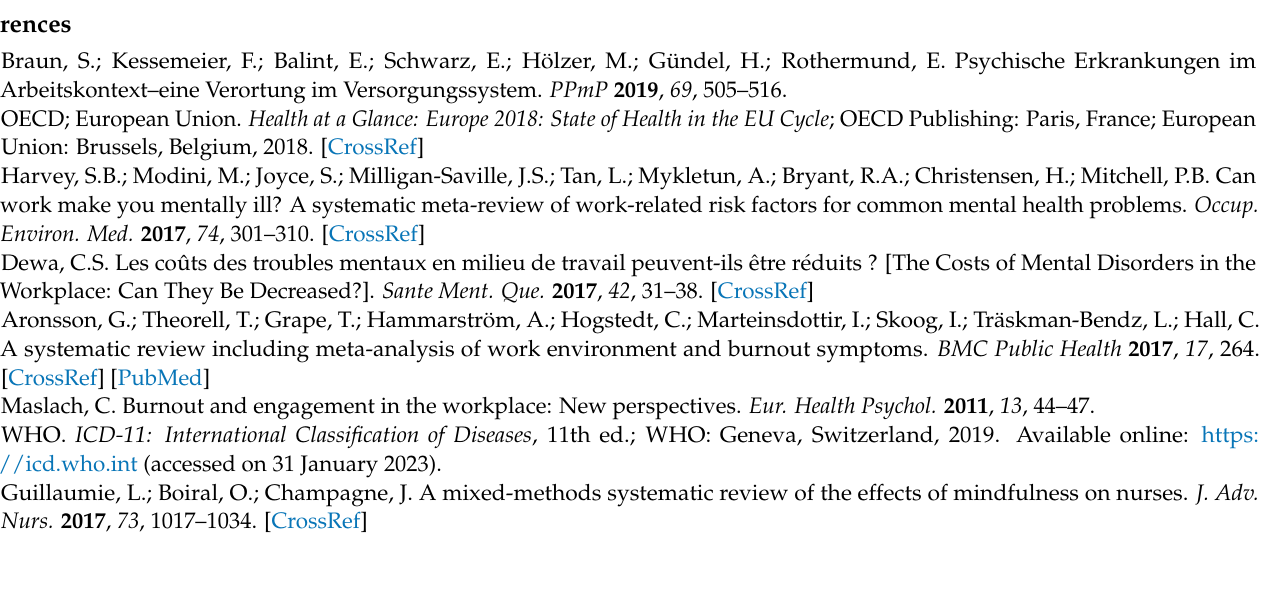
Table S3: Symptoms at admission and discharge; Table S4. Symptom change of the total sample, women,